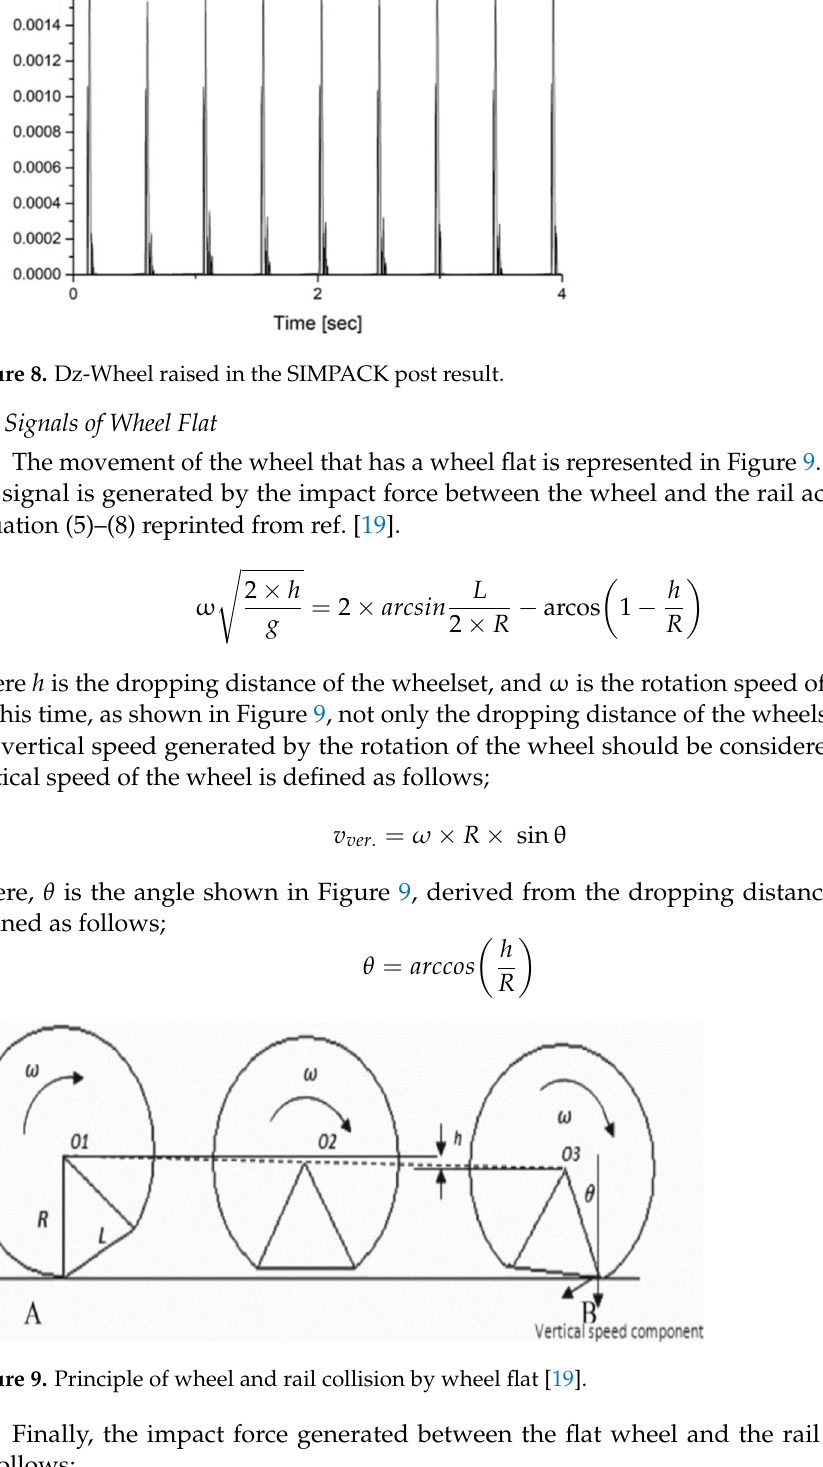
Figure 10. Acceleration signals of x, y, and z axis due to wheel flat impact against rail. Figure 11. Schematic of the instrumentation setup for wheel flat measurements [21]. 3. Signal Processing to Improve Deep Learning Results 3.1. Pre-Processing of Train, Validation, and Test Data Using the Signal Processing Method